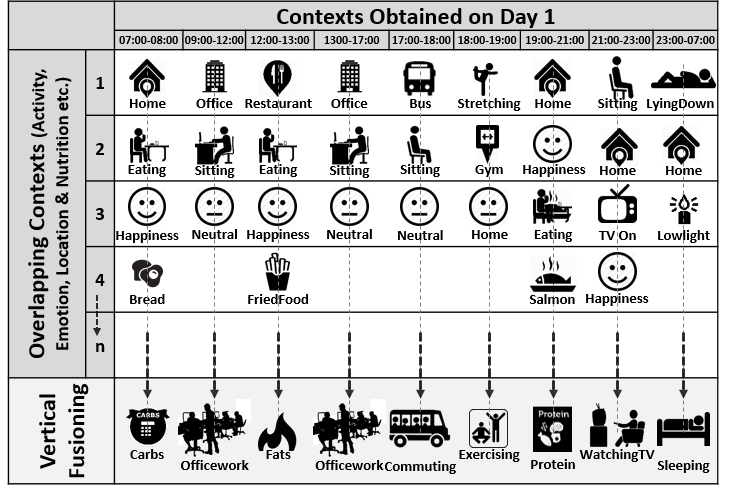
Figure 7. Example scenario explaining Vertical Fusioning using overlapping Low-level